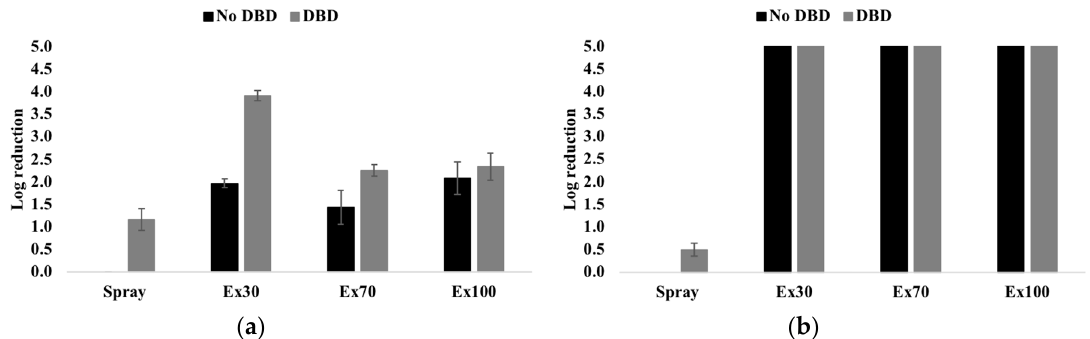
Figure 6. S. aureus ( a ) and E. coli ( b ) reduction of the untreated and DBD-plasma-treated samples with PVP–AgNPs after 24 h of